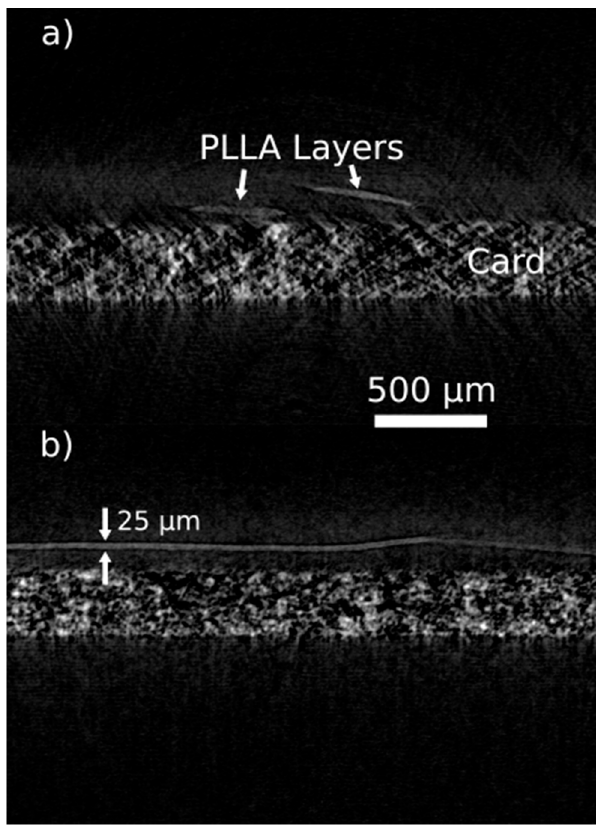
Figure 10. Cross-sectional µ-CT images ( a ) end-on ( b ) side-on of 3D-printed PLLA layers ( L PLLA = 25 µm and e PLLA = 0.0025) after washing to remove PVA layer. Samples are mounted on a